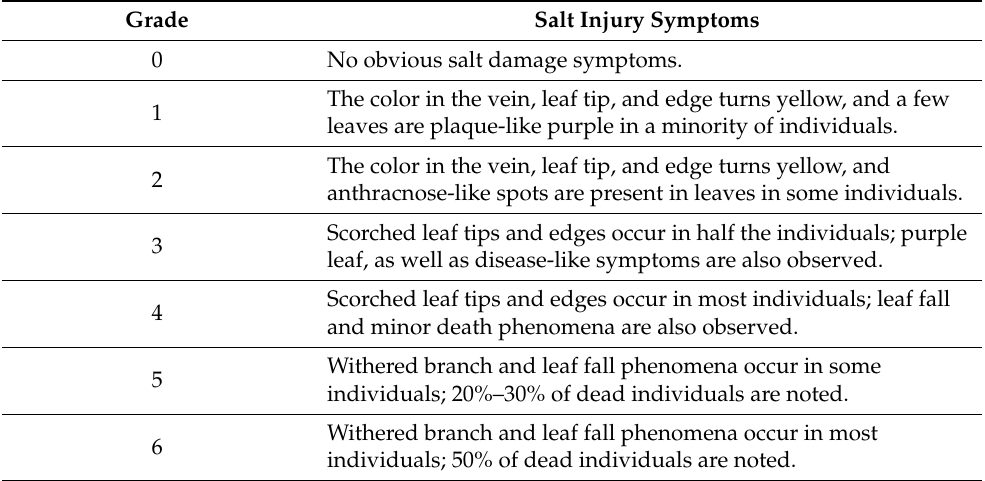
Table 2. Classification system of salt injury degree based on symptoms of seedling.